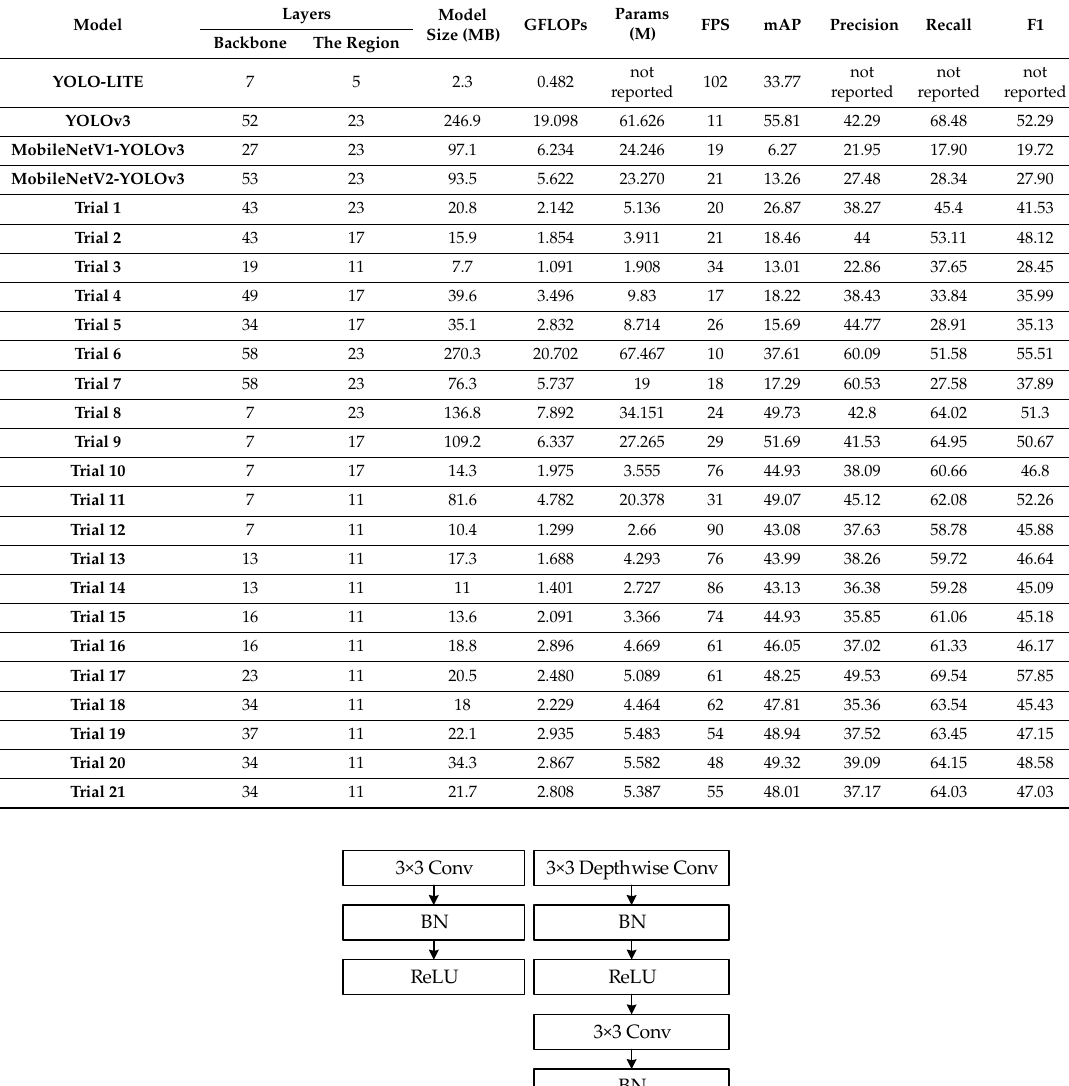
Table 6. Results of di ff erent trials using PASCAL VOC dataset.